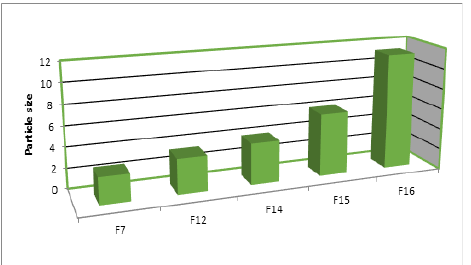
Figure 3. Particle size (μm) of ITZ